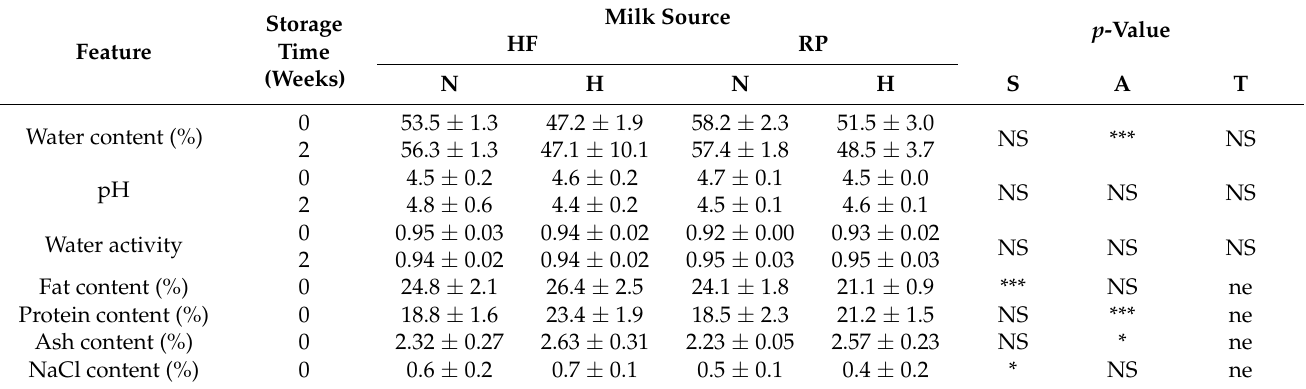
Table 1. Basic chemical composition, acidity, and water activity of cheeses (mean ±